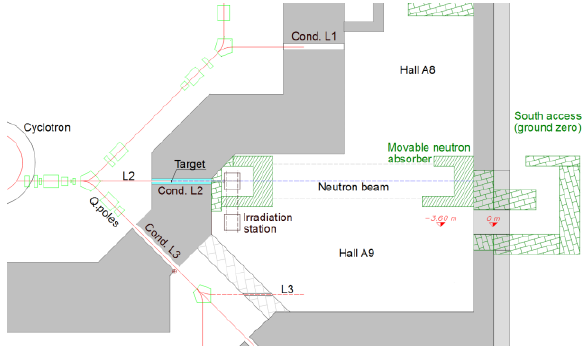
Fig. 1 Floorplan of the L shaped NEPIR experimental area (Halls A9 and A8) and part of the cyclotron hall. The cyclotron is visible on the left. The position of the NEPIR-0 neutron production target system is placed inside the conduit through the 3m thick shield wall that separates the cyclotron hall from the experimental hall A9. A movable neutron beam absorber is schematically shown in both open and closed positions.